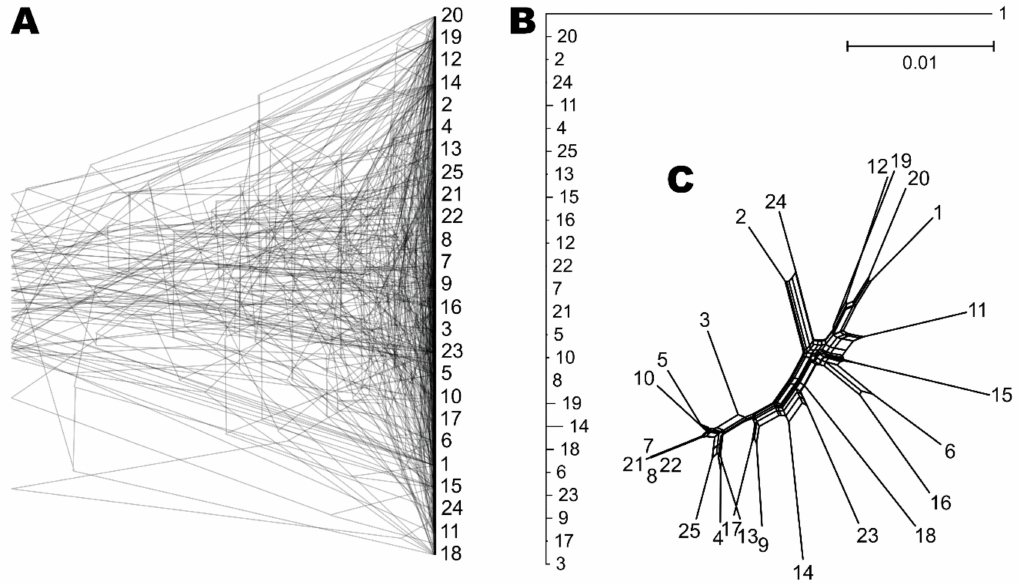
Figure 2. Phylogeny of W. mellicola strains. ( A ) Overlay of 40 core Benchmarking Universal Single-Copy Orthologue (BUSCO) gene trees estimated by PhyML 3.1 using the Hasegawa-Kishino-Yano 85 nucleotide substitution model and estimating the alpha parameter of the gamma distribution of the substitution rate categories and the proportion of invariable sites. ( B ) Majority rule consensus tree of 40 core gene trees described above. ( C ) Phylogenetic network reconstructed with the Neighbor-Net algorithm based on the dissimilarity distance matrix calculated from the SNP